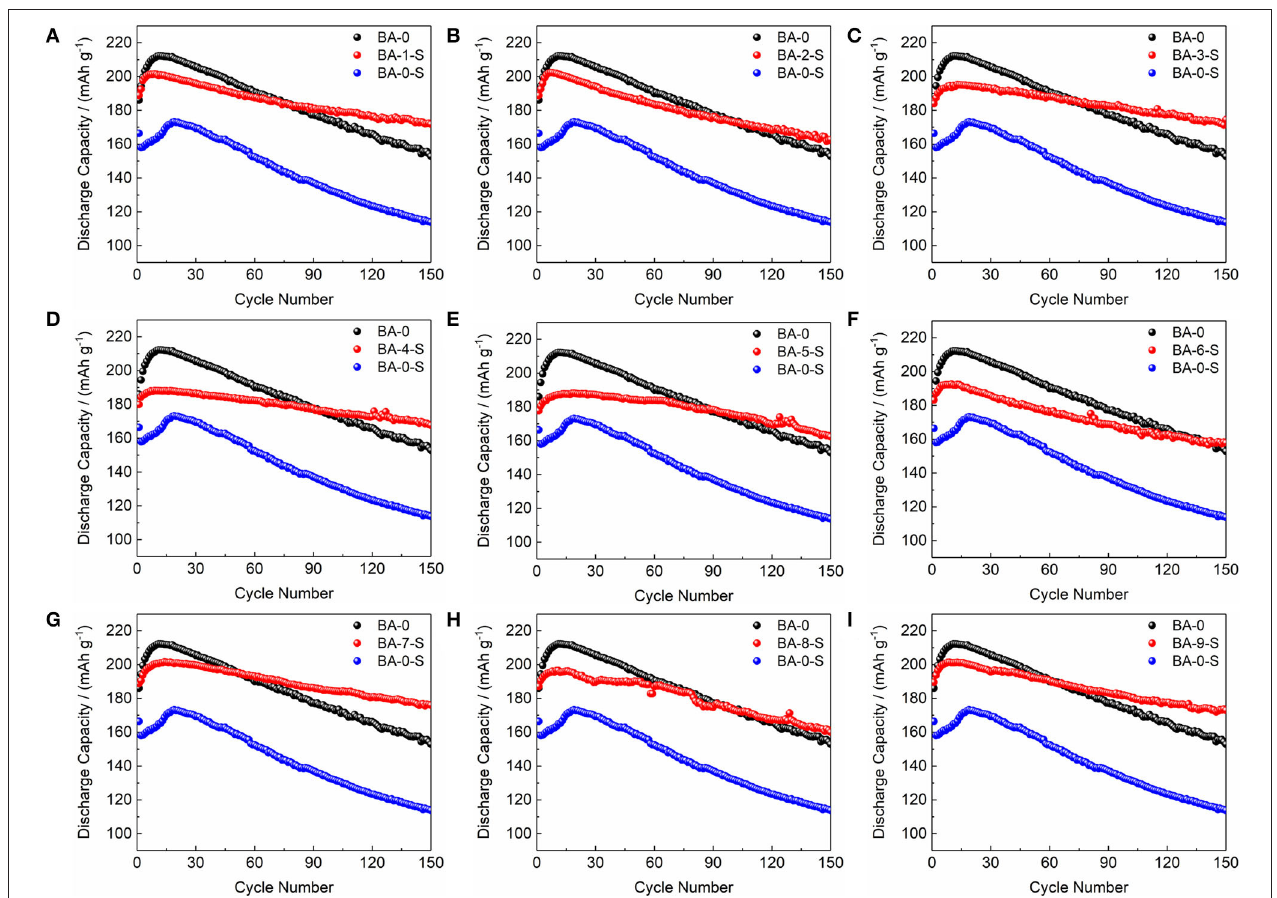
FIGURE 5 | The comparisons of cycling performance of (A–I) BA-1-S to BA-9-S with BA-0 and BA-0-S at 0.2C